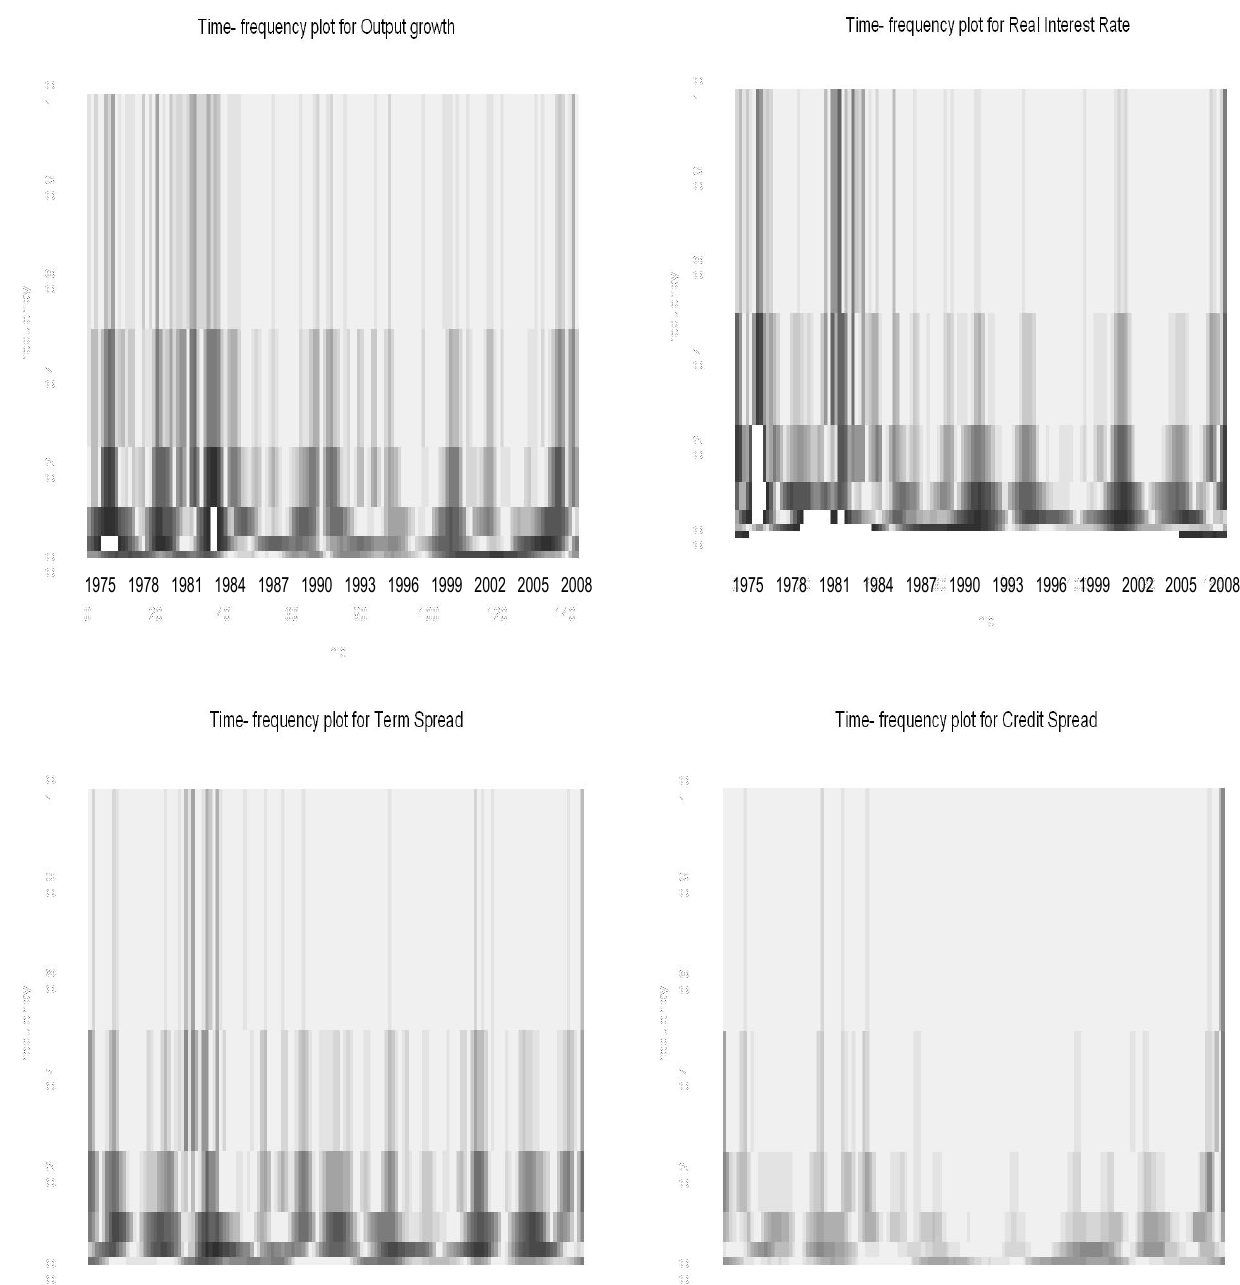
Figure 3. Time-Frequency plots: Time is measured along the horizontal axis and frequency along the vertical axis. Each wavelet coefficient is represented by a rectangular area with fine scale coefficients occupying tall thin boxes and coarse scale coefficients flat wide boxes. The modulus of the wavelet coefficient determines the gray level of each